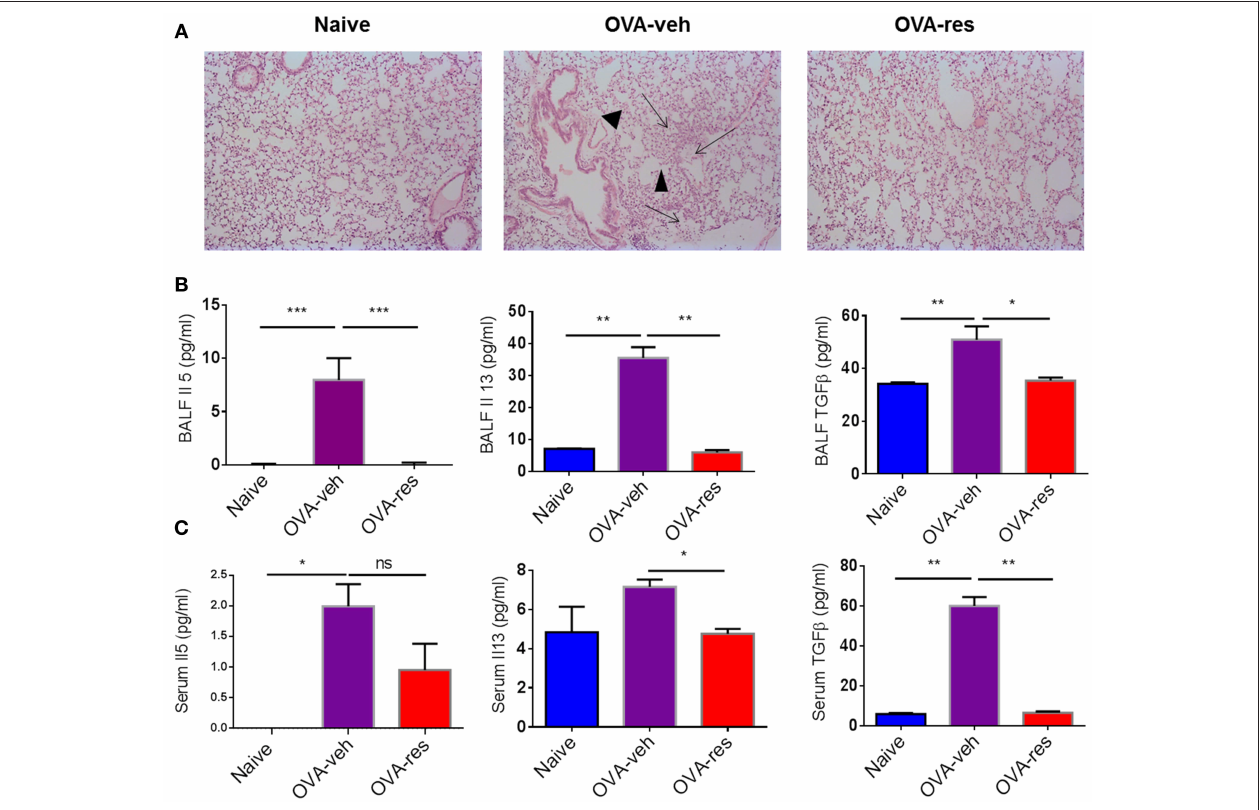
FIGURE 1 | Resveratrol attenuates Ova-induced asthma . As detailed in Methods, mice were administered Ovalbumin (OVA) intraperitoneally followed by intranasal challenge and treated with vehicle (OVA-veh) or 100 mg/kg Resveratrol (OVA-res) daily by oral gavage for 2 weeks and sacrificed on day 15. (A) Histopathological analysis of the lungs. Significant thickening was observed in the alveolar walls and inflammatory cell infiltration as well as accumulation of edematous fluid in the alveolar spaces (arrows) and destruction of airways (arrowheads) in OVA-veh group when compared to naïve or OVA-res groups. Measurements of asthma-associated cytokines are shown for BALF (B) and serum (C) . The number mice used are given in parenthesis: Naïve ( n = 5), OVA-veh ( n = 3), and OVA-res ( n = 3). Asterisks (*) represent significant ( p < 0.05) difference for all experiments. ANOVA and post-hoc Tukey’s tests were performed to determine the significant (* p < 0.05, ** p < 0.01, *** p < 0.001) difference between the